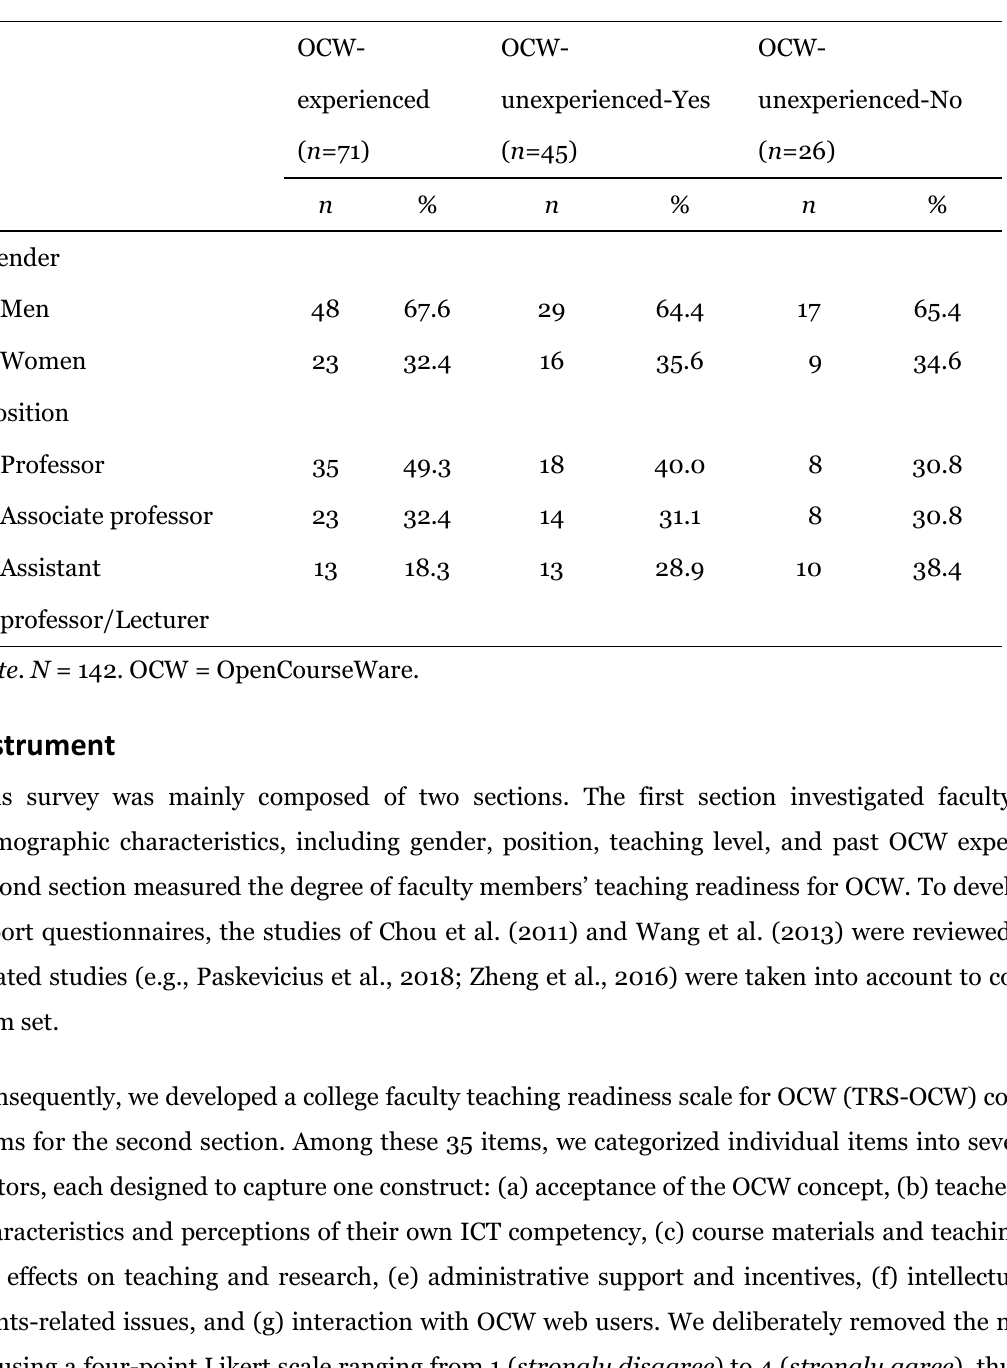
Demographic Characteristics of